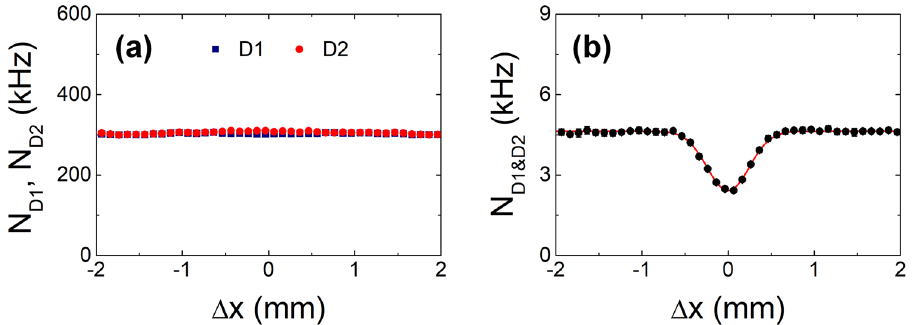
Figure 6. ( a ) Single ( N D1 , N D2 )- and ( b ) coincidence ( N D1&D2 )-counting rates as functions of the path-length difference when the interferometer arms are